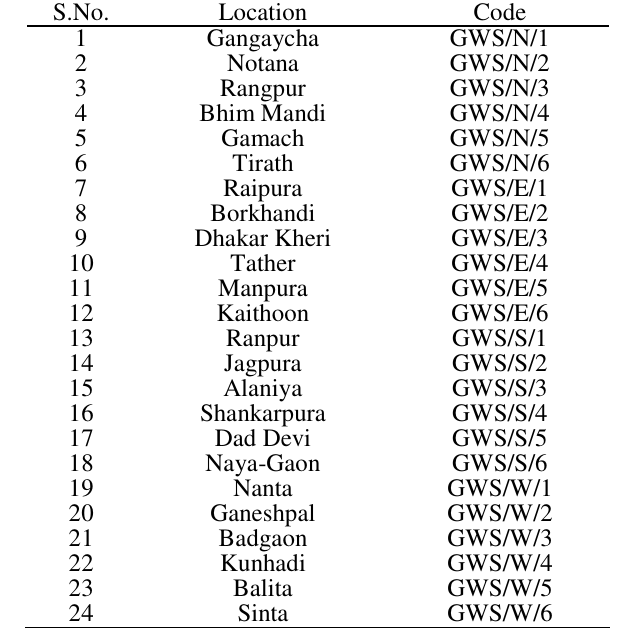
Table 2. Water quality, physicochemical study of groundwater samples (Given values are average of the respective year)